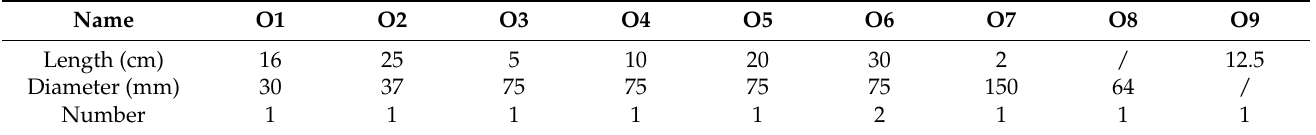
Table 3. Parameters of harmless